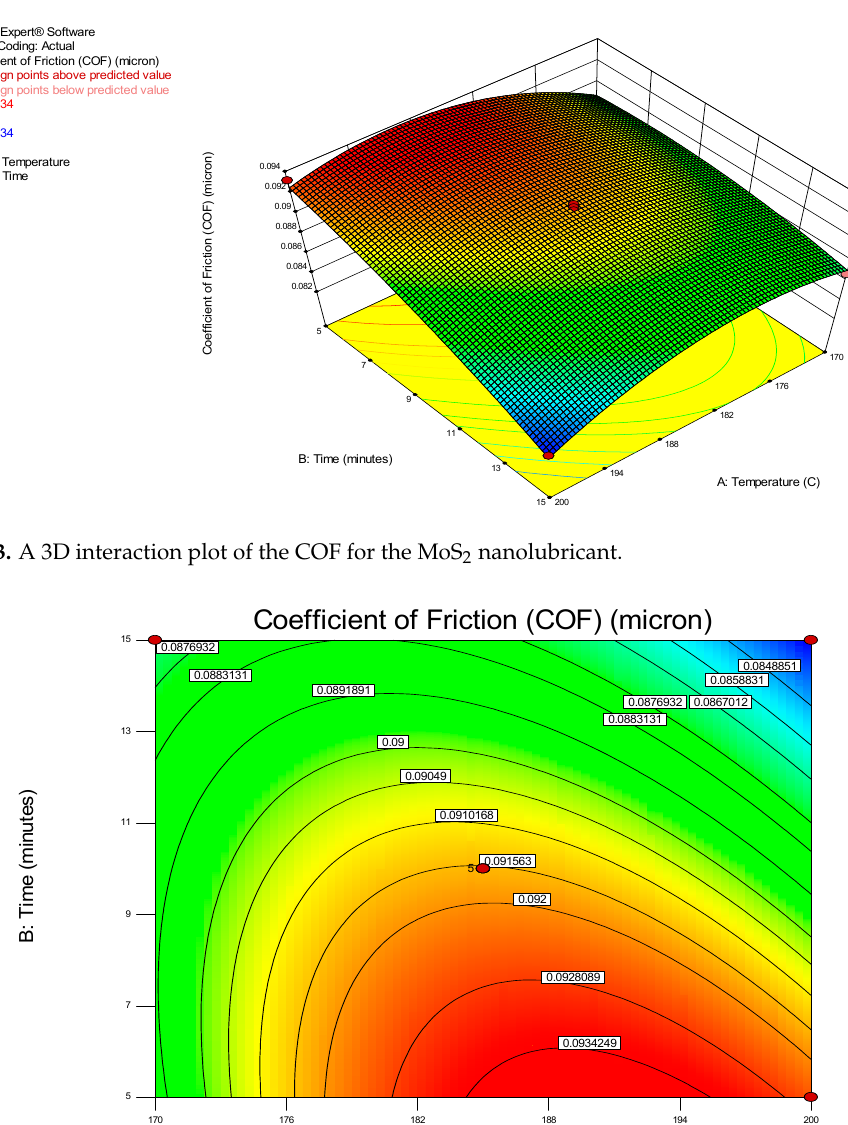
Figure 2. The normal probability plot of the COF for the MoS 2 nanolubricants.